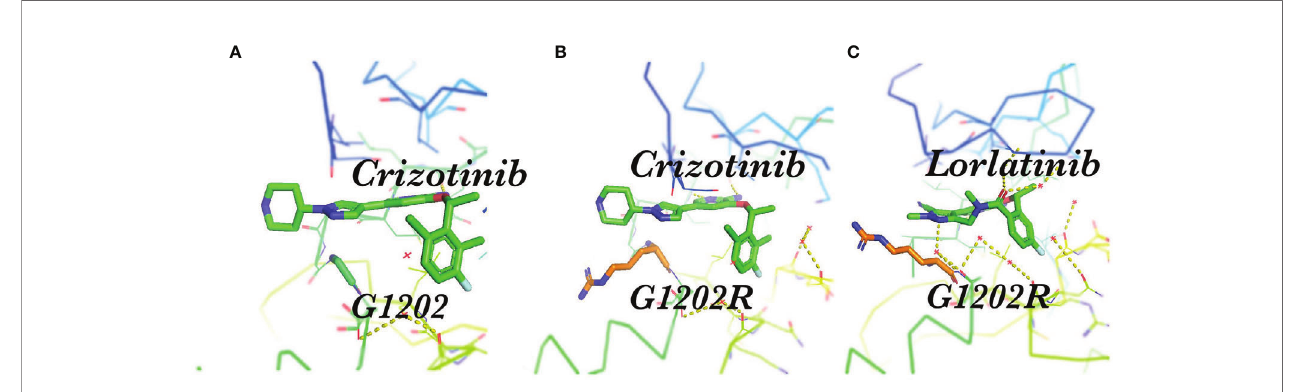
FIGURE 2 | Spatial position of G1202R and ALK-TKI. (A) Structure of the stick representation of crizotinib (green) bound to ALK G1202; (B) Crizotinib bound to ALK the G1202R mutation, showing steric hindrance; (C) Structure of the stick representation of lorlatinib (green) bound to the ALK